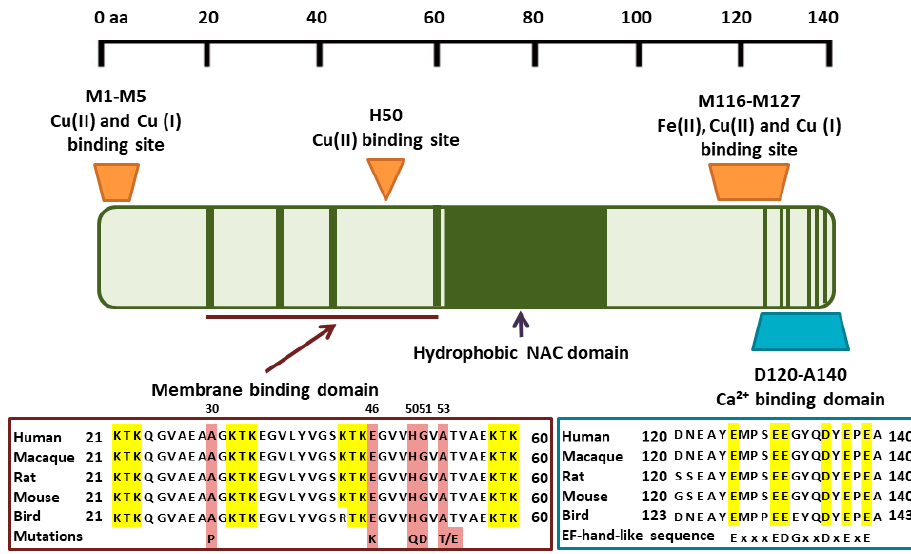
Figure 1. Metal binding to α -synuclein. Cu(I)/(II) binds to high-affinity N-terminal and lower affinity C-terminal sites. Ca(II) binds with low affinity to acidic residues in the C-terminus, overlapping with the low affinity Cu(I)/Cu(II) and Fe(II) binding sites. Mutated residues in familial PD are highlighted in brown. KTK repeats in the vesicle membrane binding domain are highlighted in yellow. Conserved residues in the C-terminus thought to mediate Ca binding are highlighted in yellow.